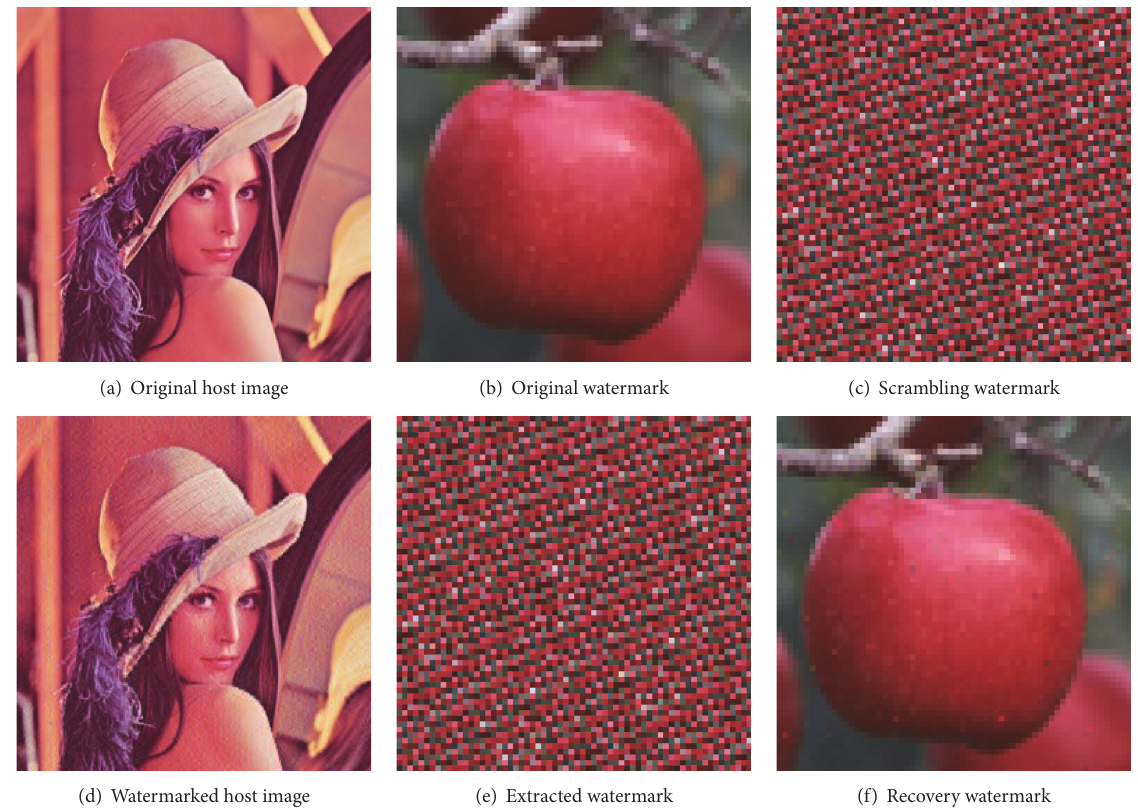
Figure 4: 256 × 256 host image with scale factor 0.28.